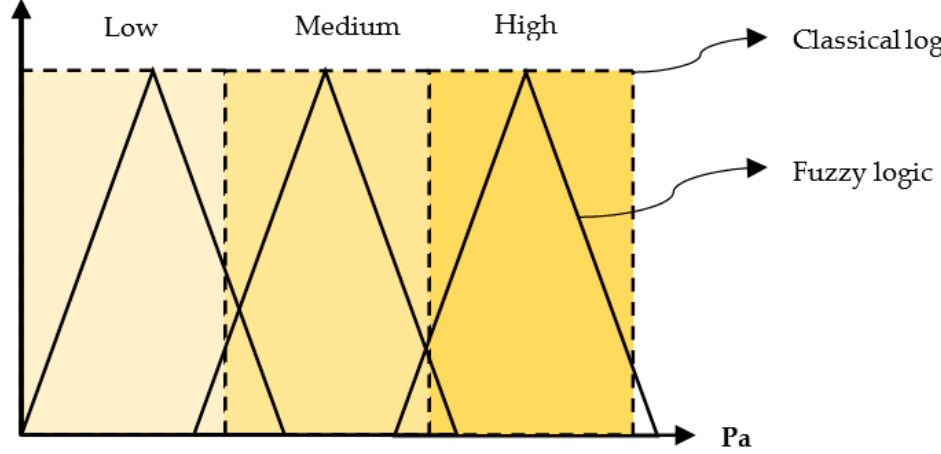
Figure 19. Representations of classical and fuzzy logic sets [162].